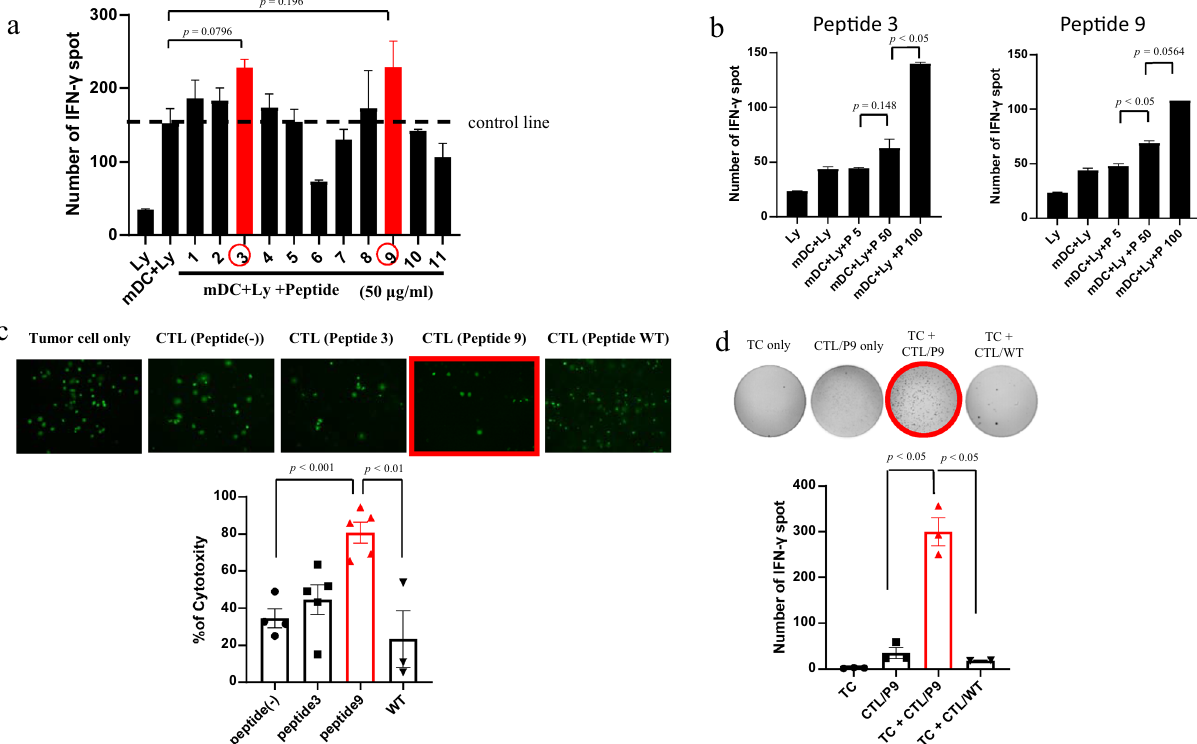
Figure 3. Response of cytotoxic T lymphocytes stimulated by neoantigen peptide-pulsed mature dendritic cells (mDCs). ( a ) IFN-γ ELISpot response of peripheral blood lymphocytes stimulated by neoantigen peptide- pulsed mDCs. The final concentration of peptide was 50 µg/ml. The mean number of IFN-γ ELISpots ± SEM is shown (n = 2). ( b ) Dose-dependent increase in the IFN-γ ELISpot response of peripheral blood lymphocytes stimulated by peptide 3- or 9-pulsed mDCs. The final concentrations of peptides were 5, 50, and 100 µg/ml. The mean number of IFN-γ ELISpots ± SEM is shown (n = 2). ( c ) Cytotoxicity assay of CTLs induced by 4 weeks of coculture with neoantigen-pulsed mDCs. Numbers of calcein-positive living tumour cells were significantly decreased by co-culture with CTLs stimulated with peptide 9-pulsed DCs. The mean % of cytotoxicity ± SEM is shown (n = 3–5). ( d ) IFNγ-release responses by peptide 9-pulsed mDC stimulated with CTLs against autologous tumour cells. Ly: lymphocyte; mDC, mature dendritic cell; TC, tumour cell; CTL/P9, CTLs induced by peptide 9-pulsed DCs; CTL/WT, CTLs induced by wildtype peptide-pulsed DCs. The mean number of IFN-γ ELISpot ± SEM. is shown (n =